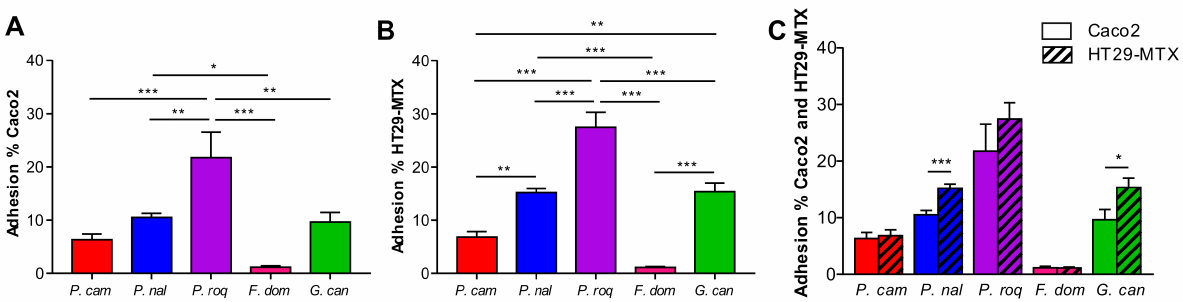
Figure 1. Adhesion properties between filamentous strains. Adherence capacity of Penicillium camemberti ( P. cam ), P. nalgiovense ( P. nal ), P. roqueforti ( P. roq ), Fusarium domesticum ( F. dom ), or Geotrichum candidum ( G. can ) on ( A ) Caco-2, ( B ) HT29-MTX, and ( C ) both cell lines. * p < 0.05, ** p < 0.01, *** p <